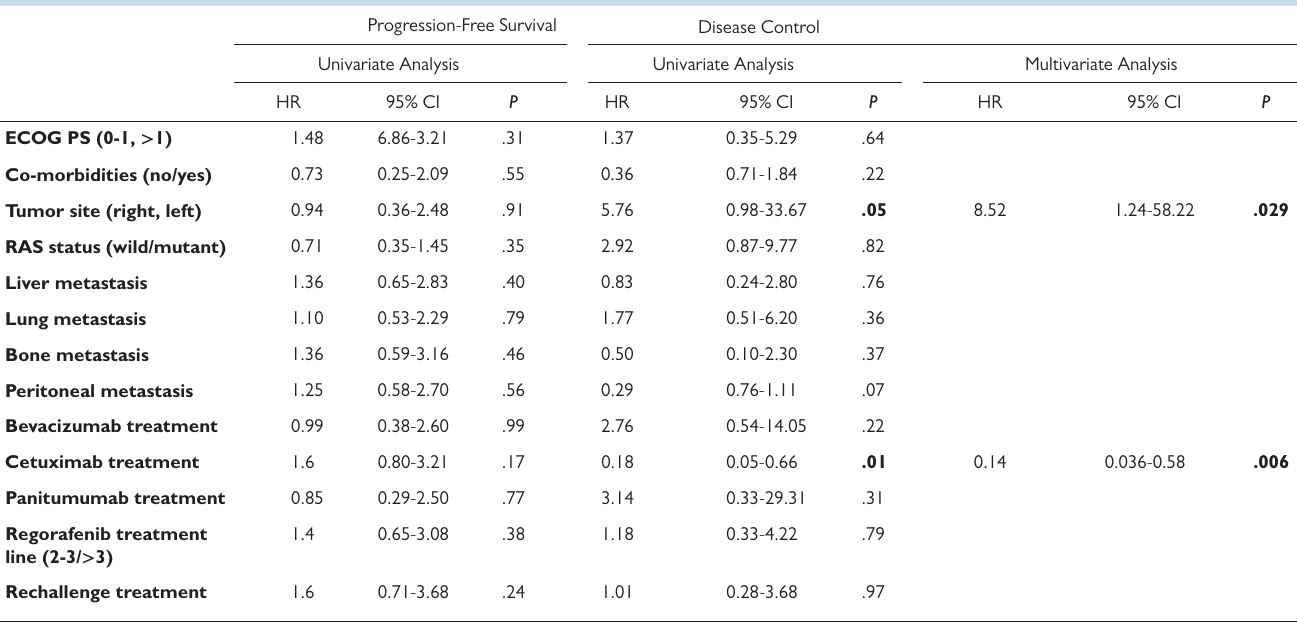
Table 2. Univariate and Multivariate Analysis Results for Progression-Free Survival and Disease Control